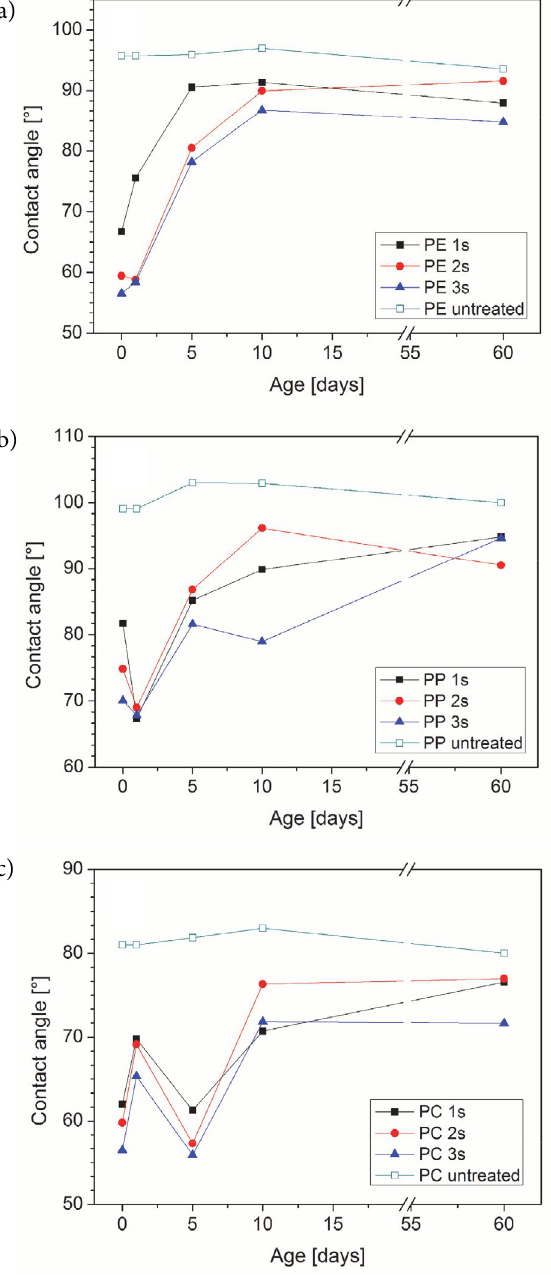
Figure 3. Measurement of contact angle of water on a) PE, b) PP and c) PC substrates after various DBD plasma